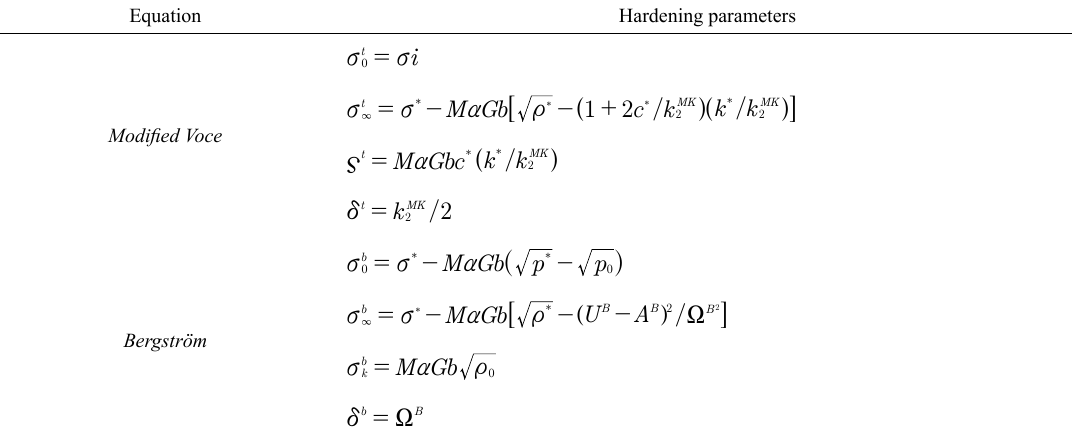
Table 1. Phenomenological correspondence of micromechanical